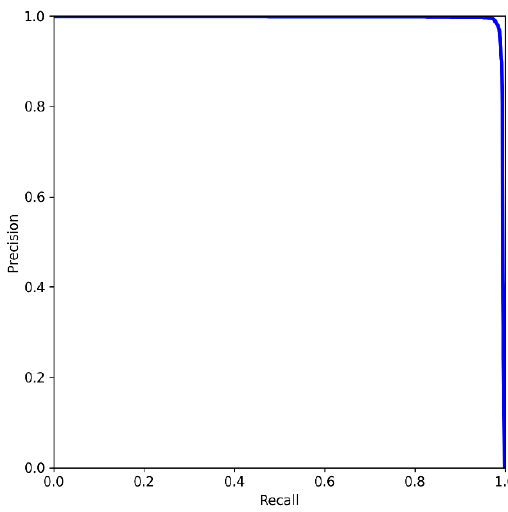
Figure 11. Precision – recall curve.